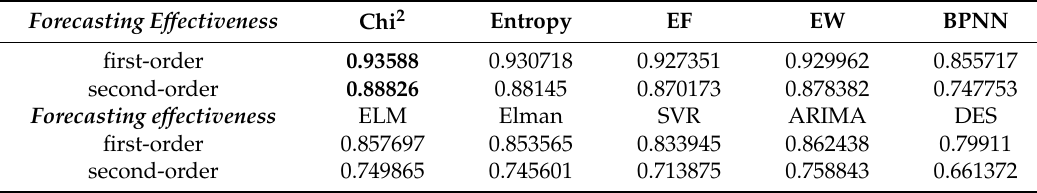
Table 16. Forecasting effectiveness of different forecasting models for hourly time horizon wind speed